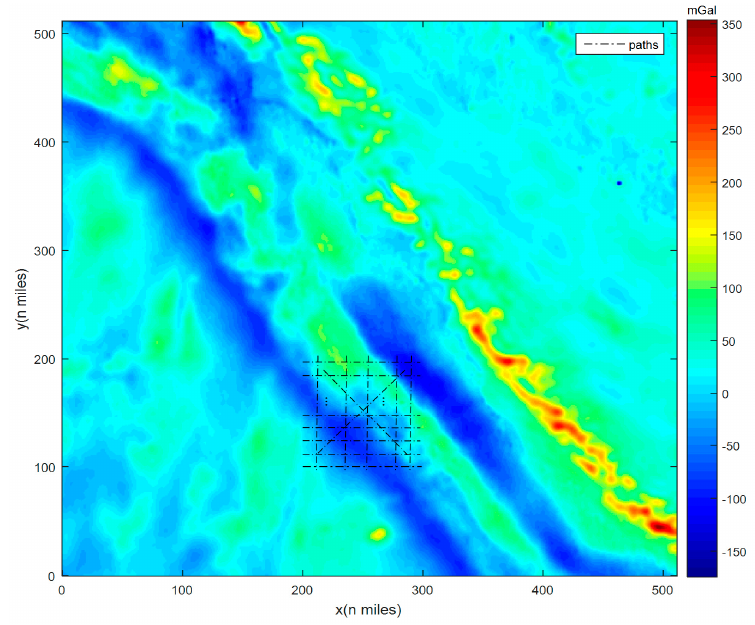
Figure 2. Paths cross the matching area in the gravity map.